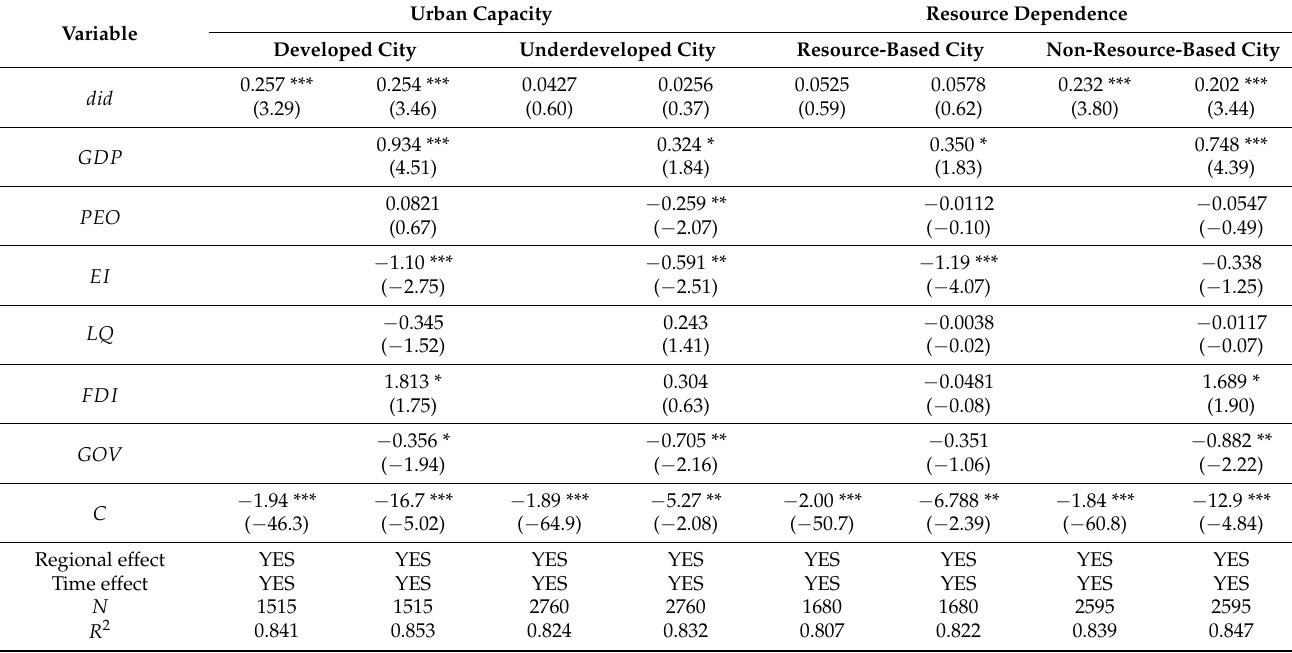
Table 8. Regression results of cities with different urban capacity and resource